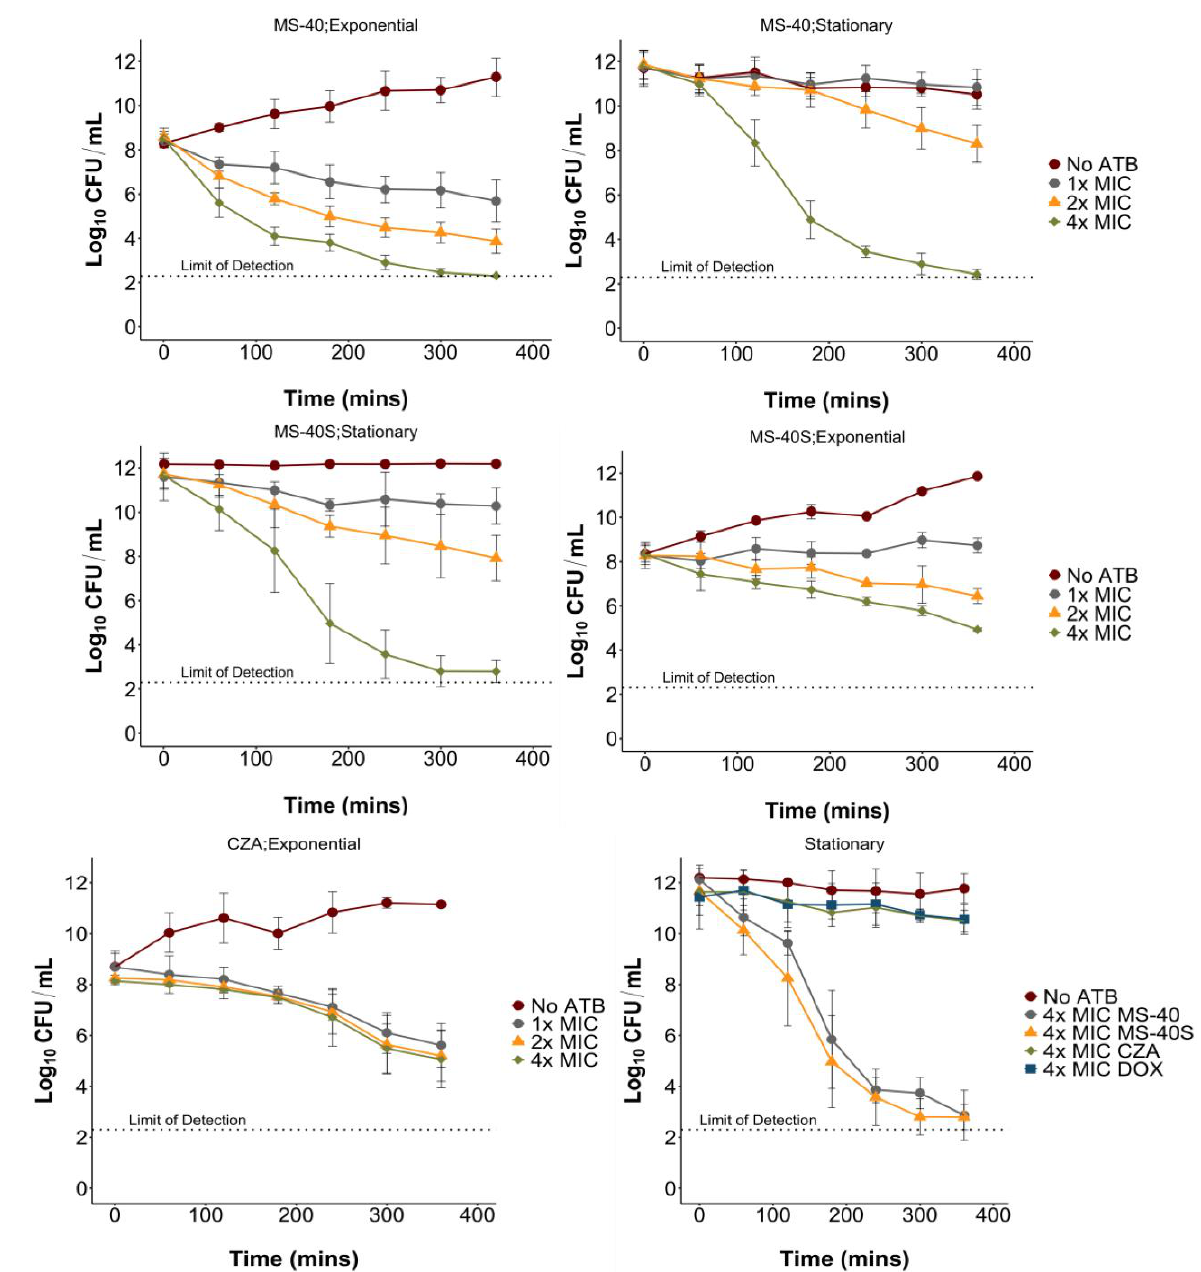
Figure 3. Exponential and stationary time kills of Burkholderia cenocepacia K56-2. The compounds used were MS-40, MS-40S, and ceftazidime–avibactam (CZA) at 1×, 2×, and 4× MIC, as well as doxycycline (DOX) at 4× MIC. The cultures were grown overnight for stationary phase cells or grown overnight, subcultured, and grown to early exponential phase. Samples were taken every hour for six hours to determine CFU/mL. No ATB; no antibiotic.